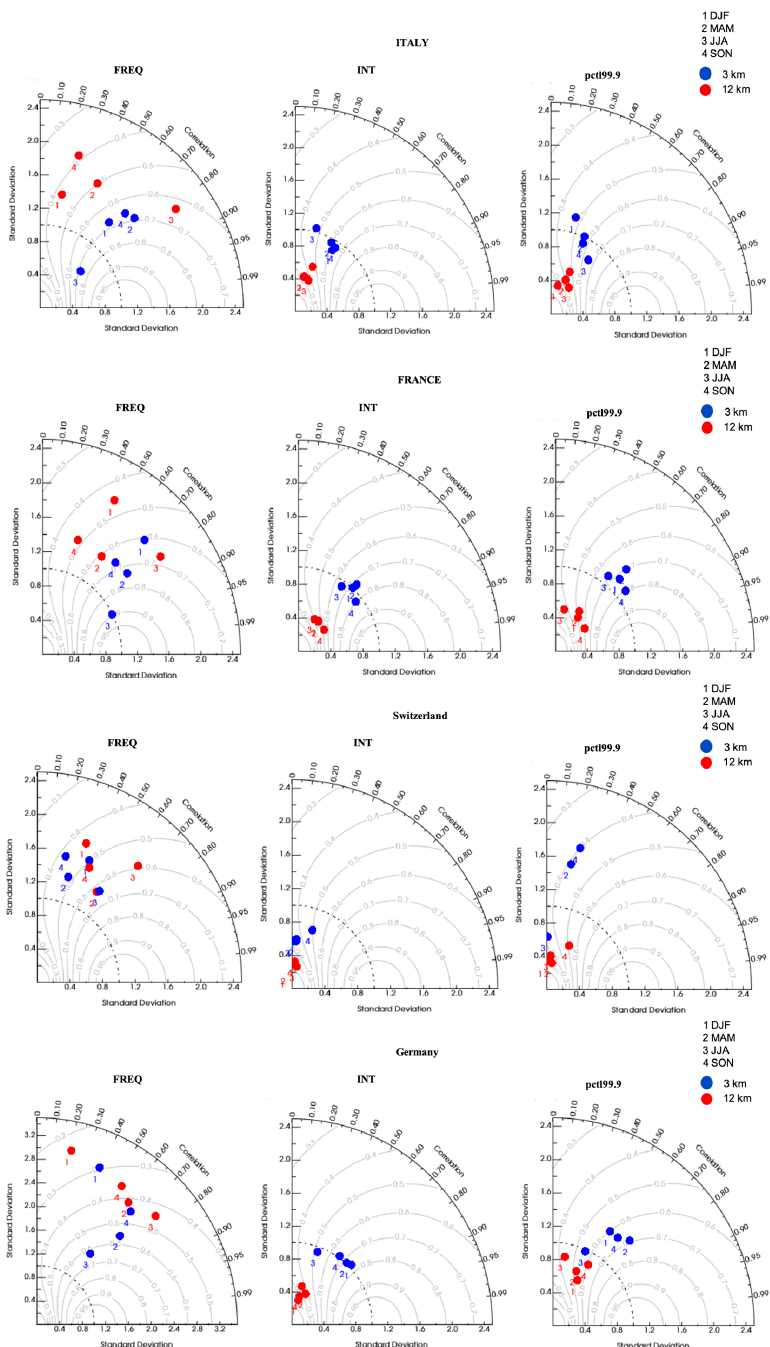
Figure 9. Spatial Taylor diagrams exploring model performance in terms of the spatial variability of seasonal hourly precipitation. The performance is explored for hourly precipitation frequency (first column), intensity (middle column), and heavy hourly precipitation (defined as 99.9th of all hourly precipitation events; last column) over four regions—Italy, France, Switzerland, and Germany (from top to bottom). The diagrams combine the spatial correlation (cos; azimuth angle), and the ratio of spatial variability (radius). The grey isolines show an additional measure of skill [97], with the skill score defined to vary from zero (least skilful) to one (most skilful). Red circles indicate results obtained by the RegCM4-NH simulation (12 km), while blue circles indicate results obtained by the CP-RegCM4-NH simulation (3